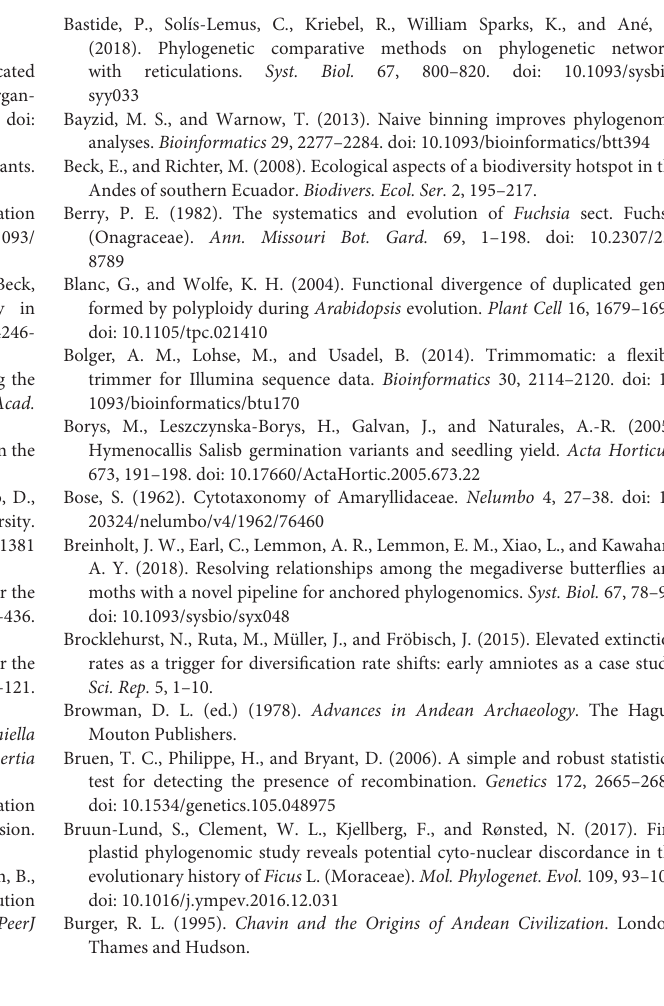
Supplementary Table 4 | Event tally for BAYAREALIKE + J biogeographic analysis of the partial plastome supermatrix best ML tree. Node numbers refer to Supplementary Figure 10